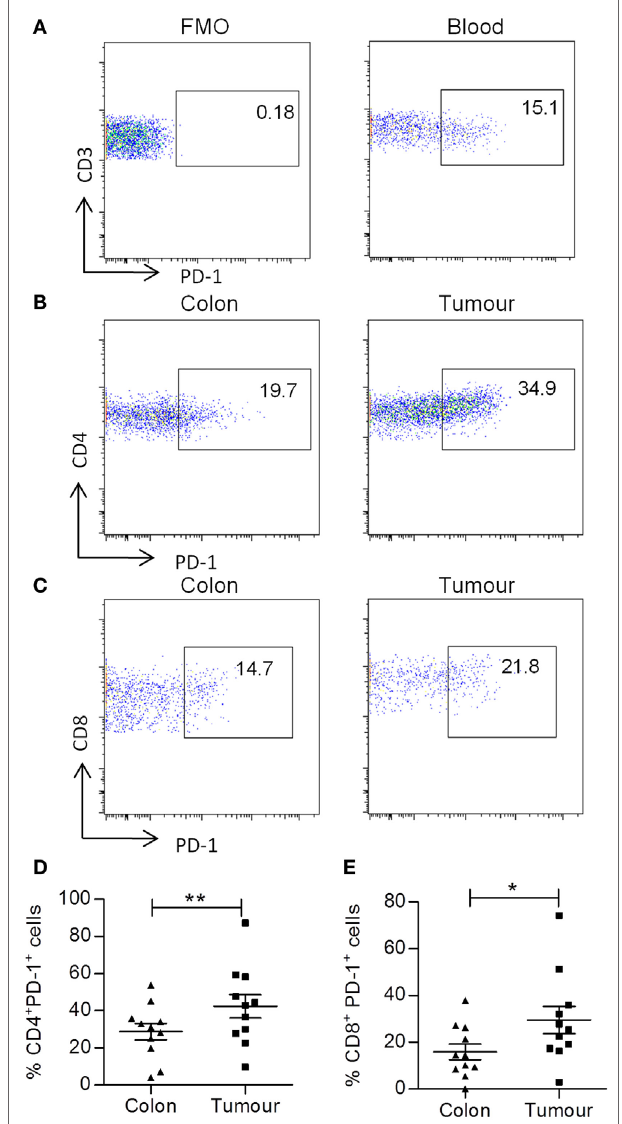
FigUre 4 | increased frequency of PD-1 expression on tumor infiltrating cD4 + and cD8 + T cells . Tumor tissue and adjacent uninvolved colonic tissue were digested and stained with antibodies specific for CD3, CD4, CD8, and PD-1. Representative FMO control (a) and PD-1 dot plots of PD-1 staining on CD3 + T cells in blood (B) , PD-1 staining on CD4 + (B) and CD8 + (c) T cells in uninvolved colon or tumor samples are shown. The graphs show the frequency of PD-1 + CD4 + (D) and CD8 + (e) T cells. * p < 0.05, ** p < 0.01 as determined by the Wilcoxon signed rank